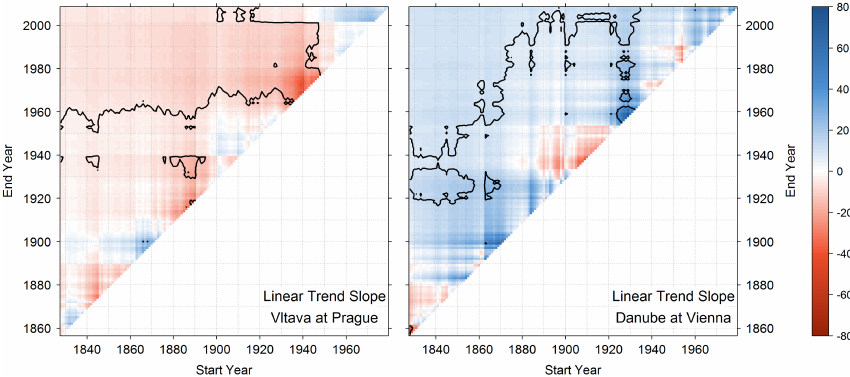
Figure 8. Trends derived from linear regression of the annual maximum flood series for the Vltava at Prague (left panel, ∼ 26700km 2 ) and the Danube at Vienna (right panel, ∼ 101700km 2 ). Regression slopes (m 3 yr − 1 ) are derived from moving windows for all possible combinations of start and end years between 1828 and 2008 (with a minimum series length of 30yrs). Blue colours indicate increasing trends, red colours decreasing trends. The black line encloses combinations of start and end years with significant trends at the 5% level (predominately long series on the top